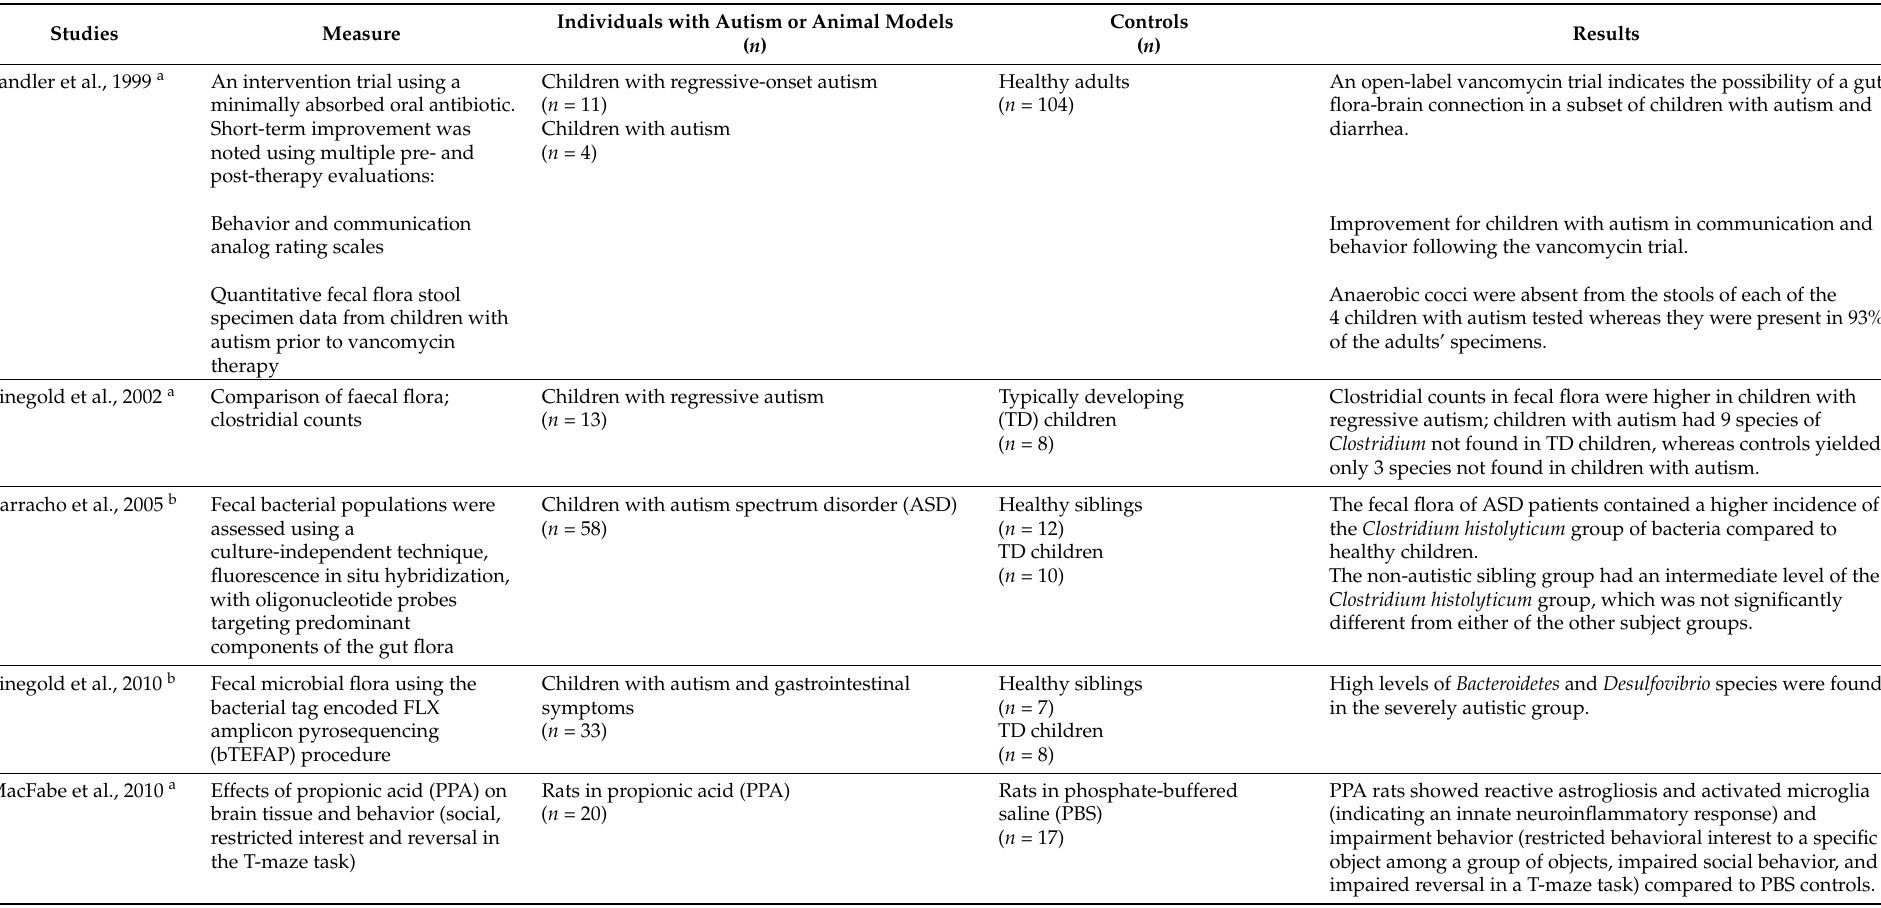
Table 2. Studies of microbiota abnormalities in autism or related animal